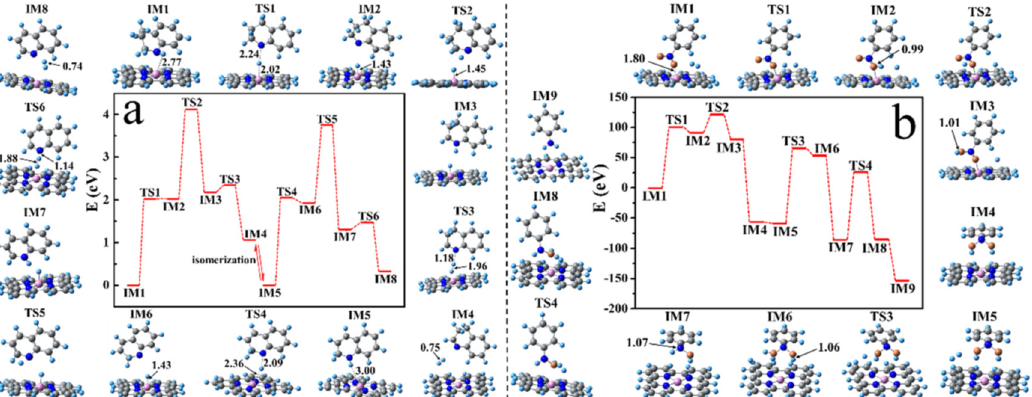
Figure 6. Transfer hydrogenation reaction of nitroarenes with saturated N-heterocycles by Co-N-C- 900 catalyst. Reprinted with permission from Ref. [32]. Copyright © Elsevier B.V. 2021.